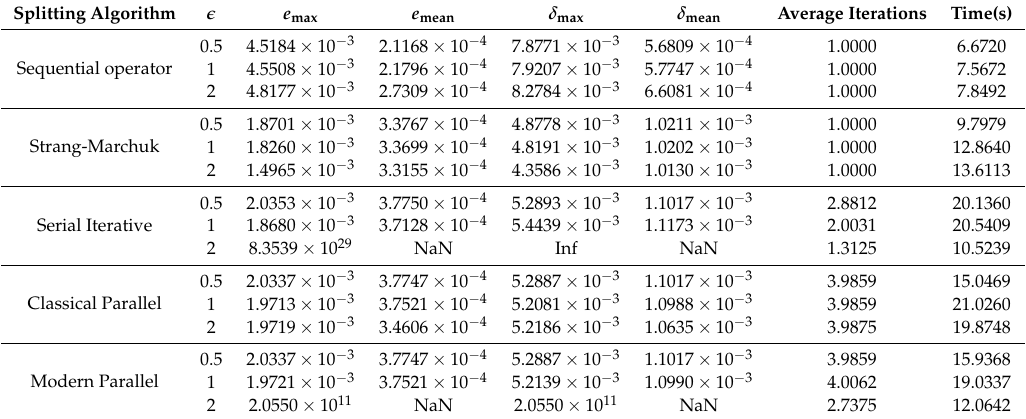
Table 15. Mixed convection-diffusion and Burgers’ equation, balanced decomposition. Results for the balanced decomposition using the second order scheme for the spatial discretization with 640 temporal subintervals and different values of parameter (cid:101) .